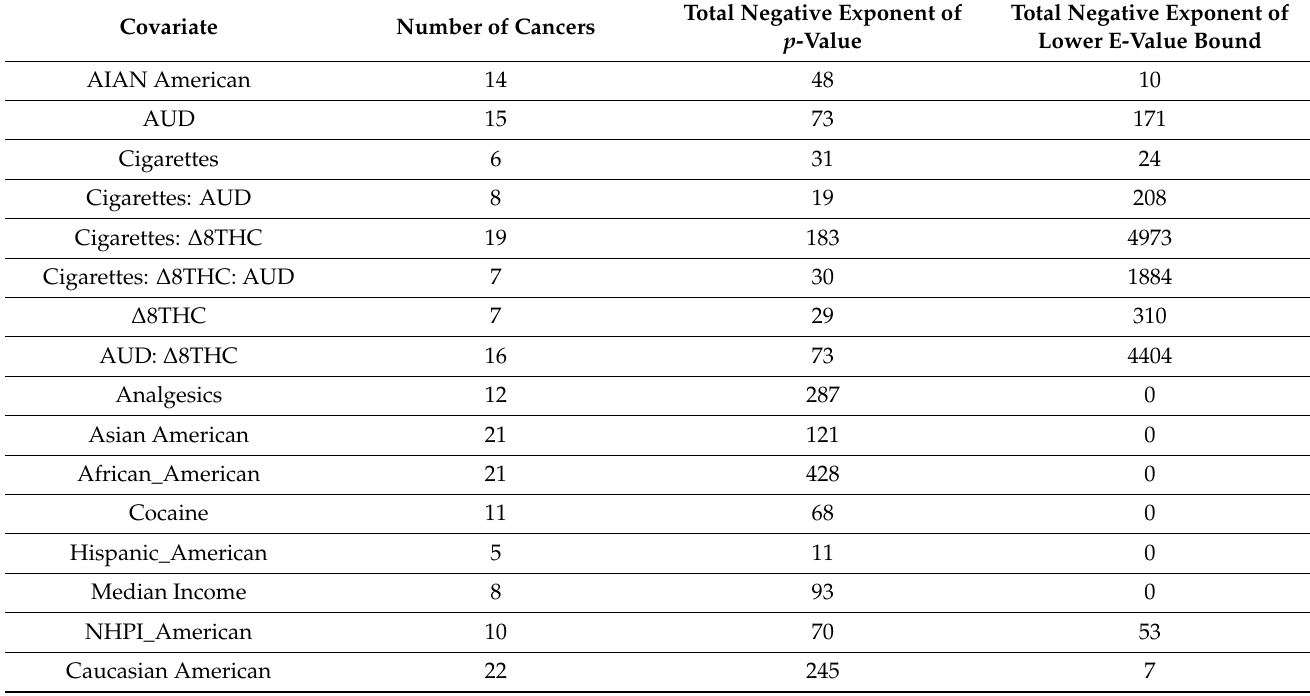
Table 3. The summary of all terms from ∆ 8THC from the interactive panel model. Total Negative Exponent of Total Negative Exponent of Covariate Number of Cancers p -Value Lower E-Value